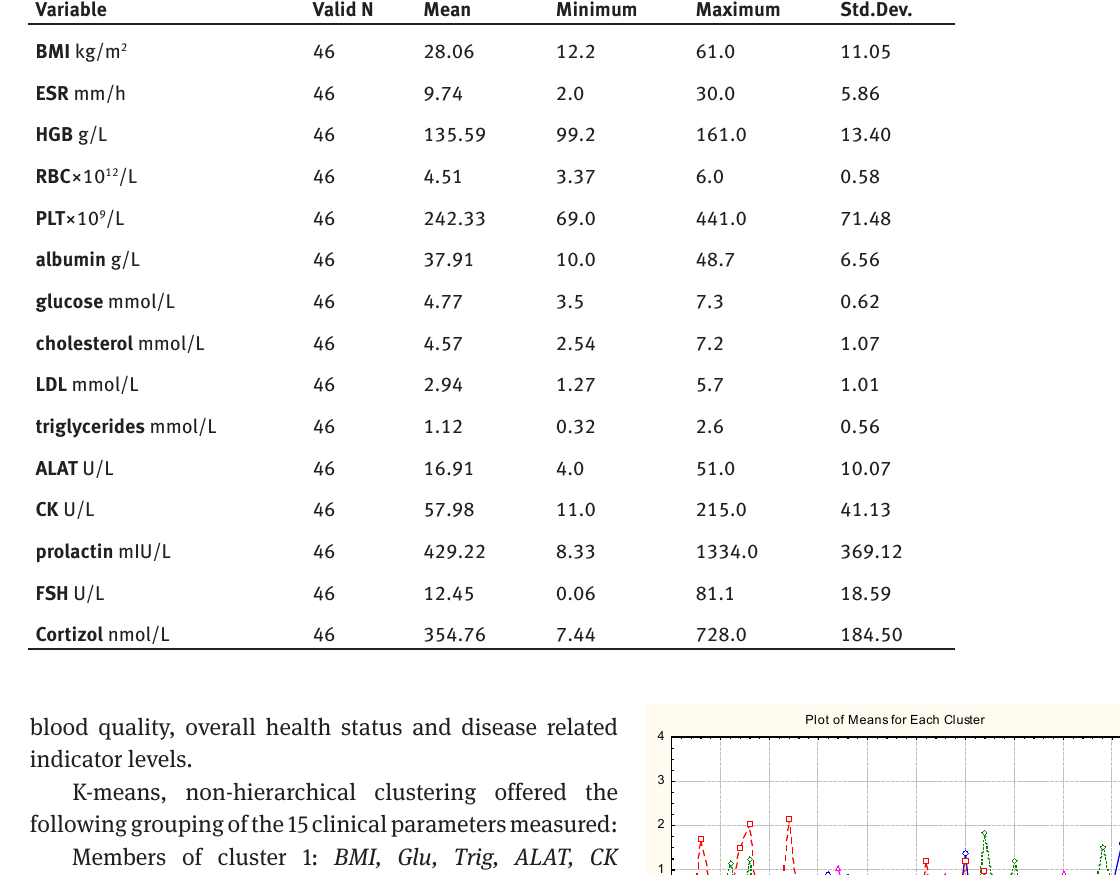
Table 1: Basics statistics.